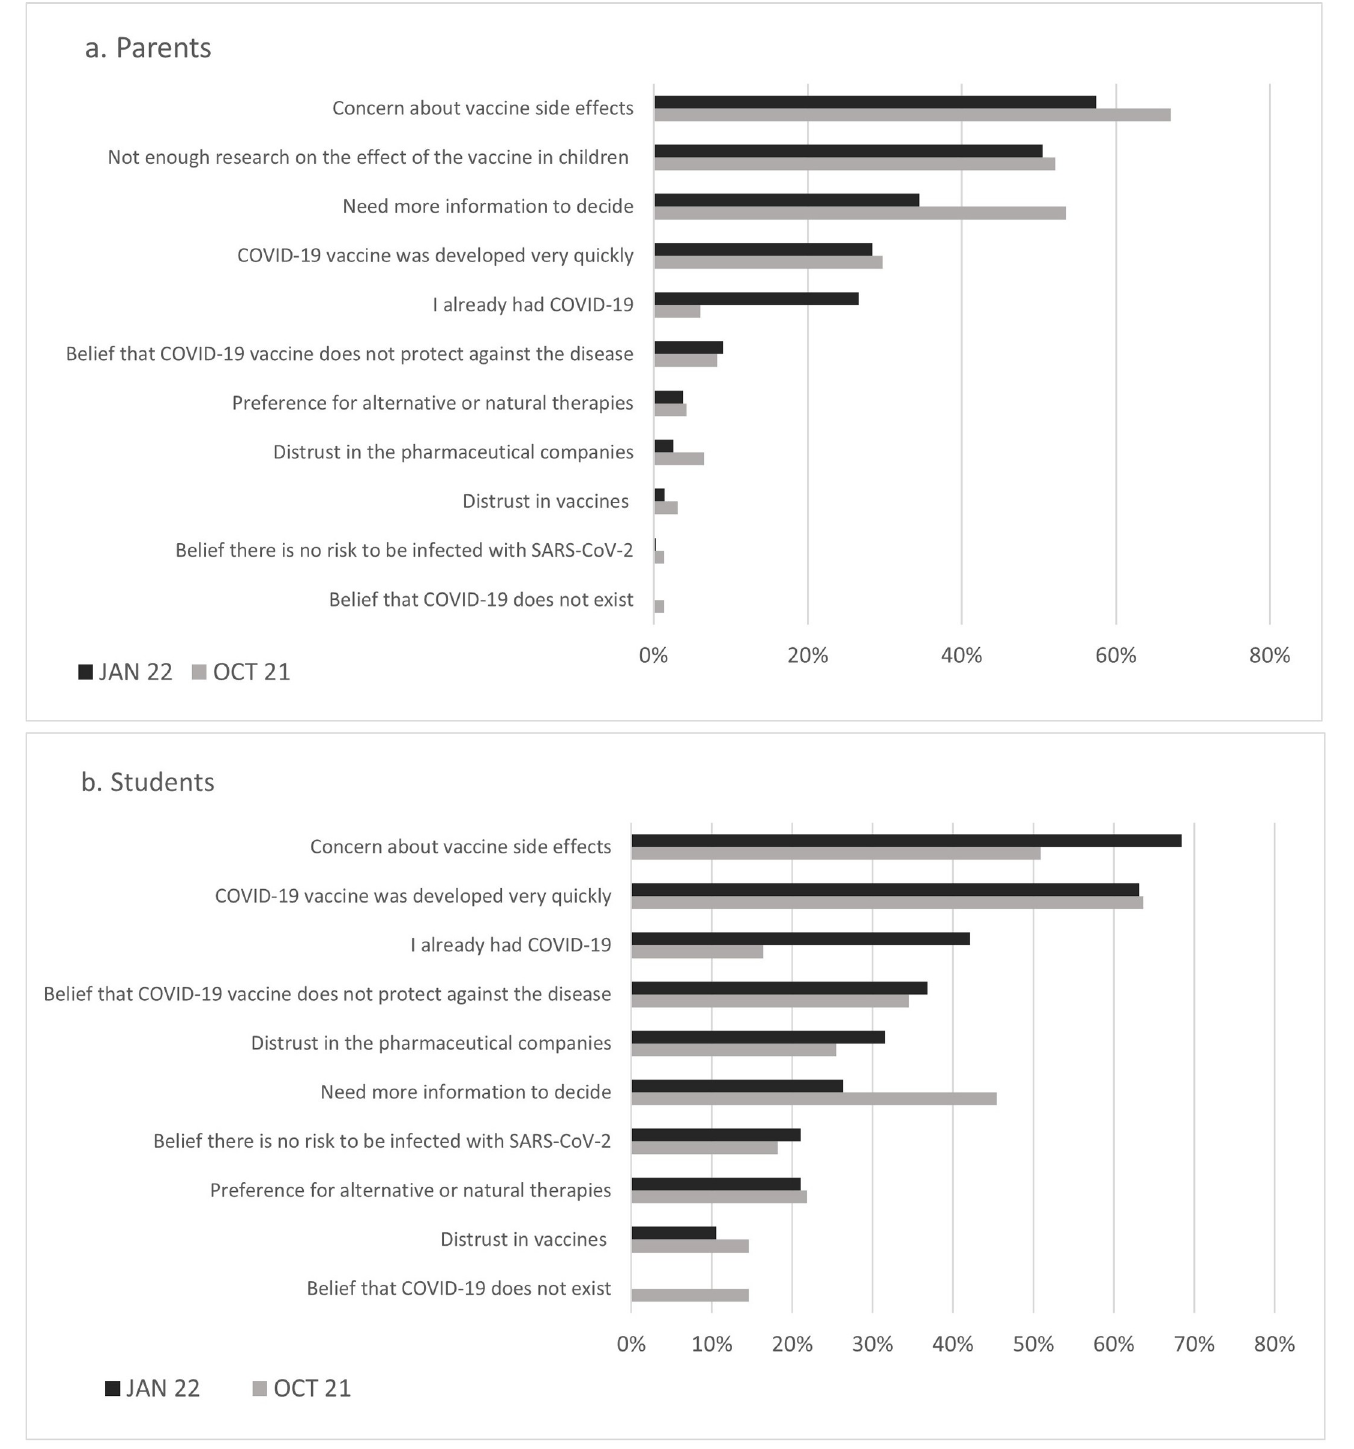
Fig 1. Reported reasons to SARS-CoV-2 vaccine hesitancy or refusal among unvaccinated. Fig 1A for parents of unvaccinated students under 16 years and Fig 1B for students over 16 years. The N for parents was 447 in October 2021 and 55 in January 2022 and for students was 345 in October 2021 and 19 in January 2022. SSNC project, Catalonia, Spain. October 2021 and January 2022.